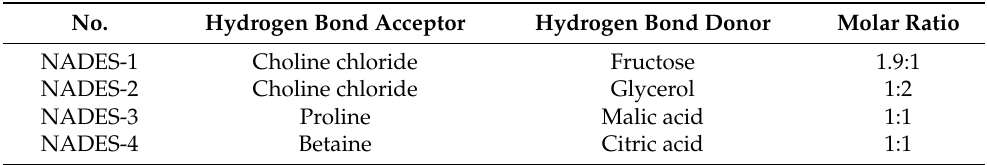
Table 1. Components and molar ratios of the